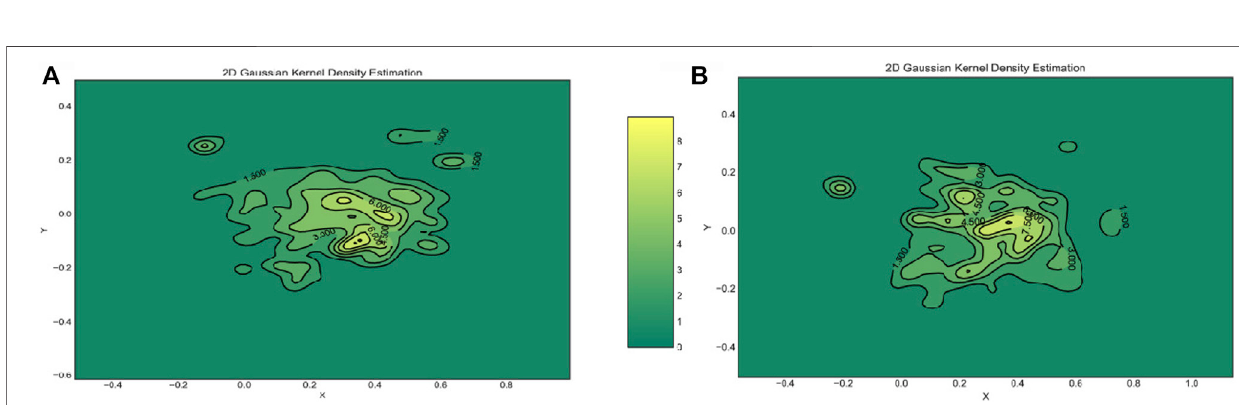
Frontiers in Robotics and AI |